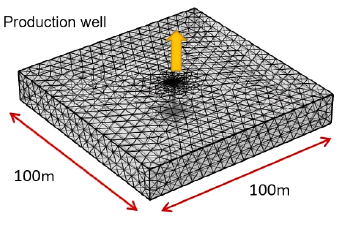
Figure 4. Verify Model Meshing Diagram.